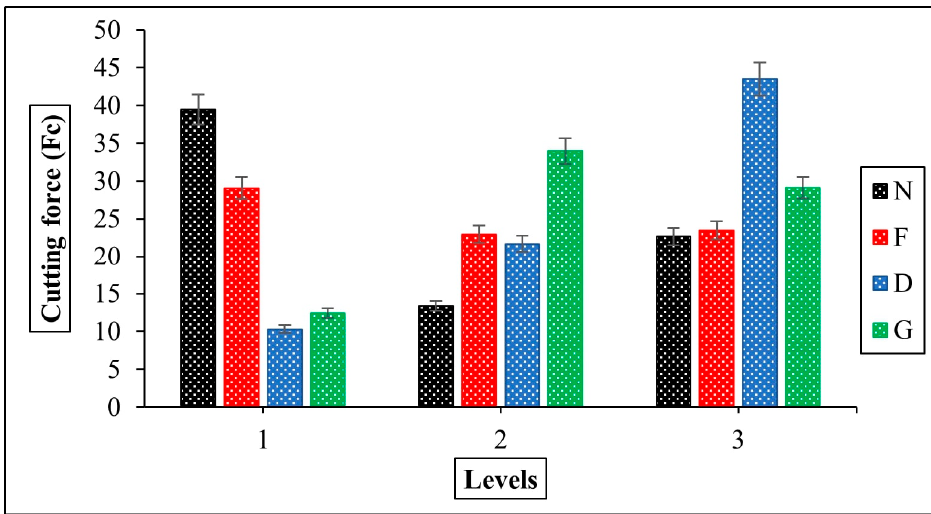
Figure 4. Cutting force vs. milling factors analysis